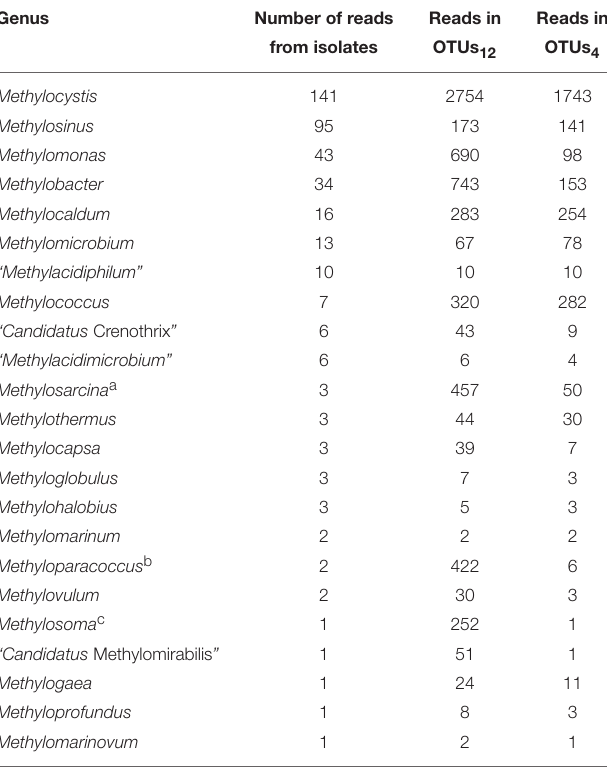
TABLE 4 | Detection frequency of methanotrophic genera in cultivation-dependent and -independent studies. Genus